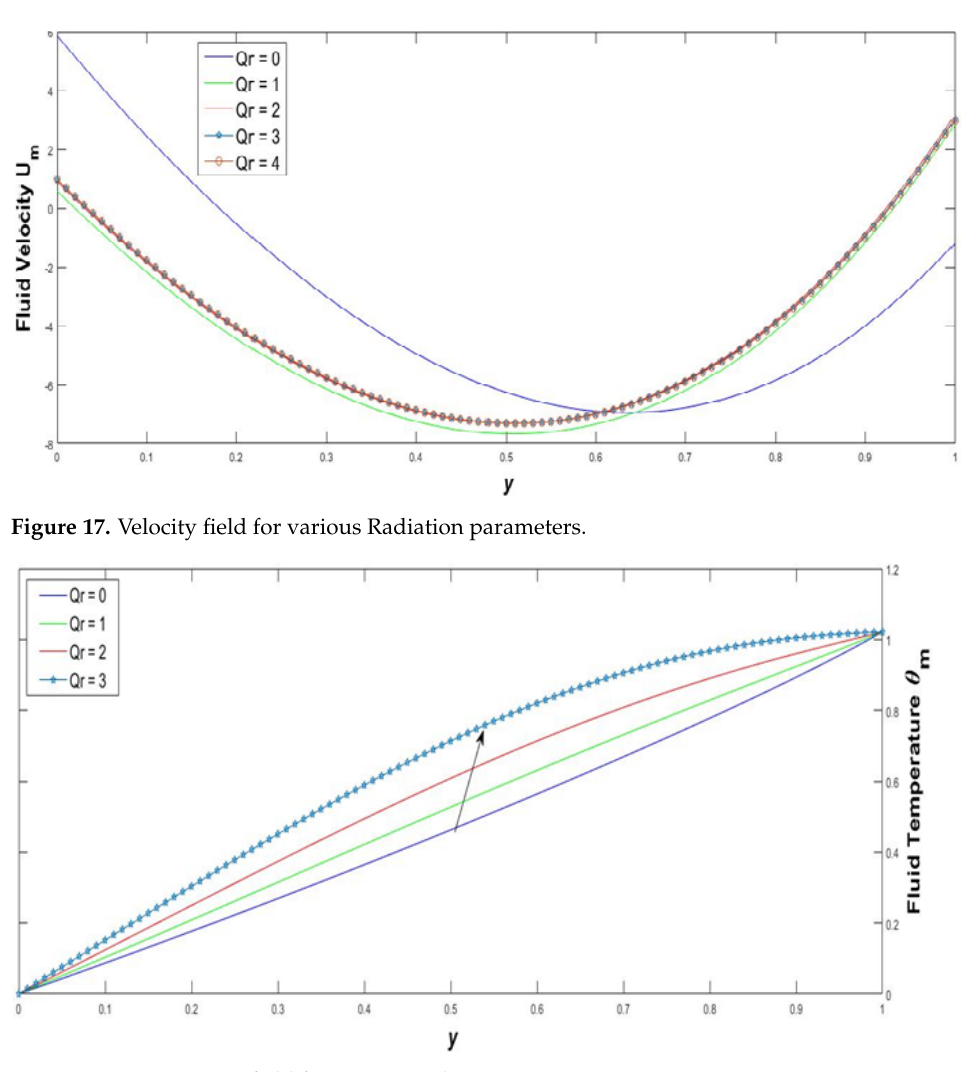
Figure 18. Temperature field for various radiation parameters.